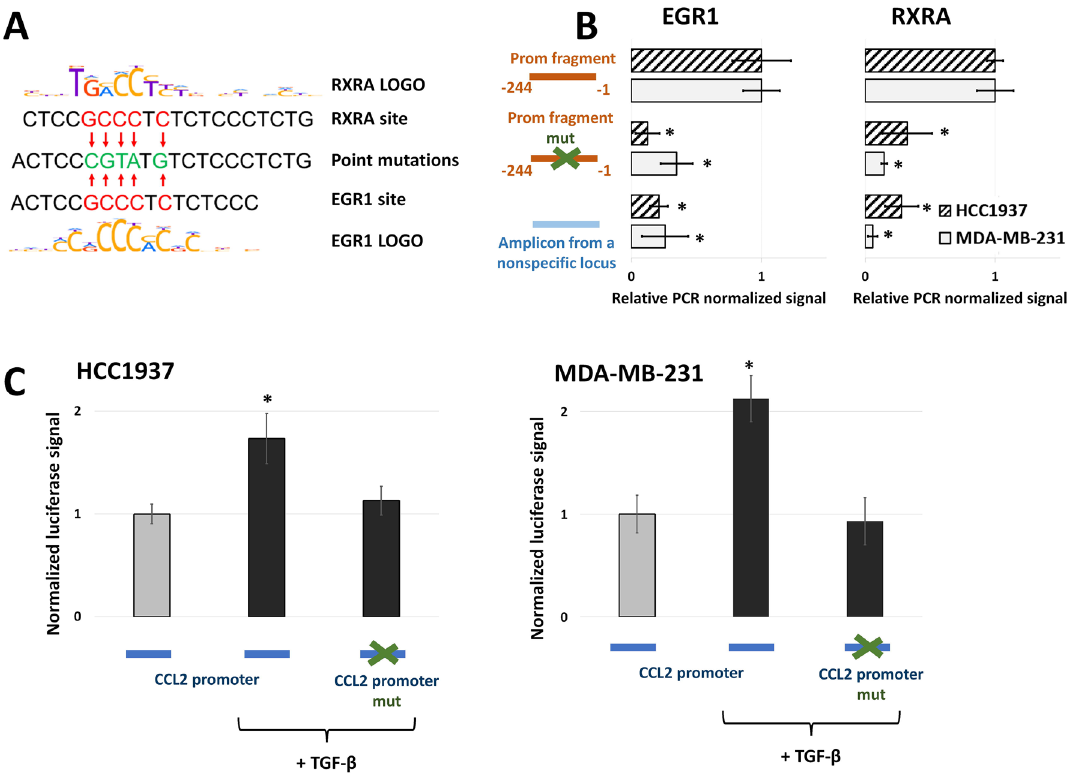
Figure 6. Point mutations in the EGR1 and RXRA binding sites in the CCL2 promoter completely abolished its activation by TGF-β1. ( A ) Position weight matrixes of the EGR1 and RXRA binding sites and the strategy of their point mutagenesis. Red arrows indicate nucleotides changes. ( B ) Point mutations of the EGR1/RXRA1 sites in the CCL2 promoter totally abrogated EGR1 and RXRA1 binding to the promoter. The efficiency of EGR1 and RXRA1 binding to different variants of the CCL2 promoter was estimated by pull-down assay with the use of nuclear extracts from MDA-MB-231 and HCC1937 breast cancer cells. The data were normalized to the normal − 244/− 1 amplicon after subtraction of the background signal (the signal for this sample is represented as 1 for each cell line). The results of five independent experiments are represented. *P < 0.01. ( C